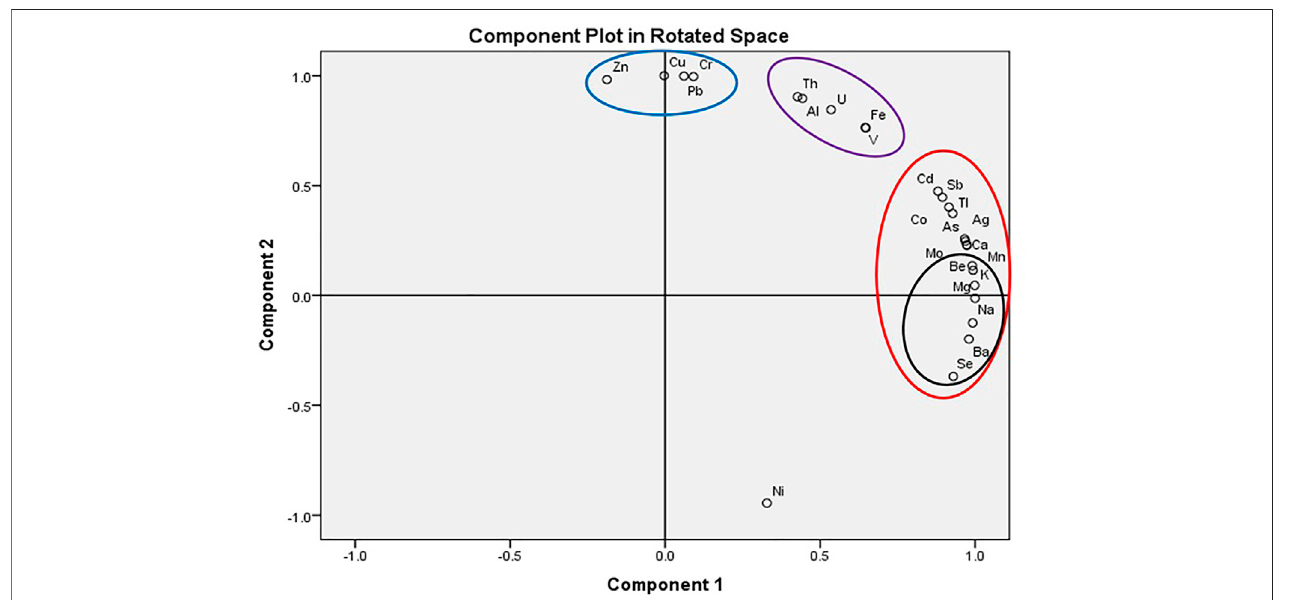
FIGURE 6 | Principal Component analysis (PCA) showing grouping of elements according to concentrations in ppm.